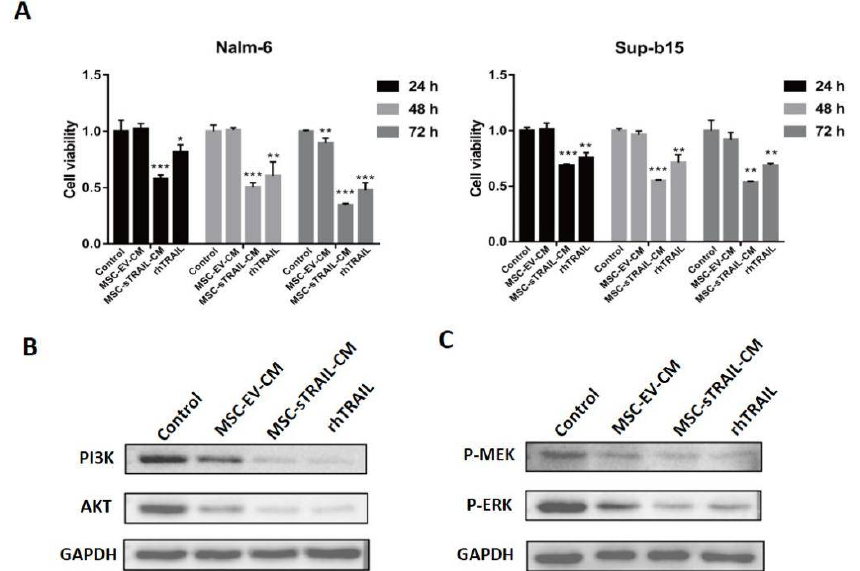
Figure 2. MSC-sTRAIL inhibits the proliferation of B-ALL cells. ( A ) MSC-sTRAIL inhibits the proliferation of Nalm-6 and Sup-b15 cells. CM: conditional medium ( n = 6 per group; Student’s t test, *, p < 0.05, **, p < 0.01, ***, p < 0.001, MSC-EV-CM group, MSC-sTRAIL-CM group, and rhTRAIL compared with control group). Nalm-6 cells were treated without (control group) or with MSC-EV-CM, MSC-sTRAIL-CM, or rhTRAIL for 48 h, then, ( B ) protein levels of PI3K and AKT were investigated by western blotting, and GAPDH was used as the inner control. ( C ) Phosphorylation levels of MEK and ERK proteins were investigated by western blotting, and GAPDH was used as the inner